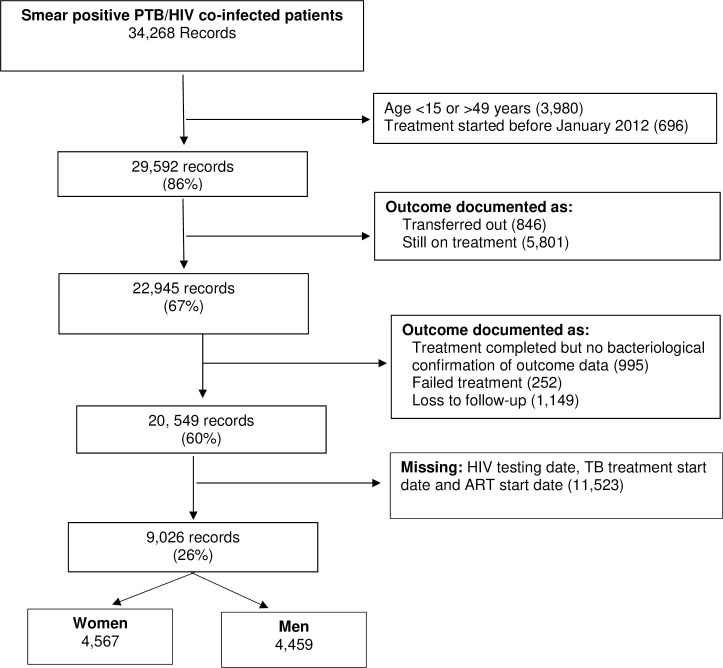
Flow chart showing smear-positive Pulmonary Tuberculosis HIV co-infected patients who were treated for tuberculosis and were eligible for analysis in Kenya, 2012 to 2015.